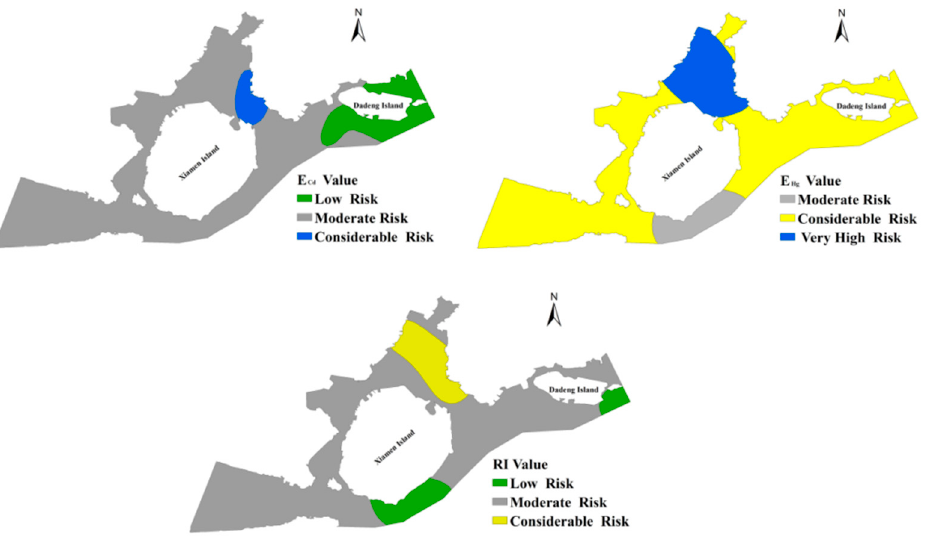
Figure 7. Spatial distribution map of the potential ecological risk of PTEs in Xiamen